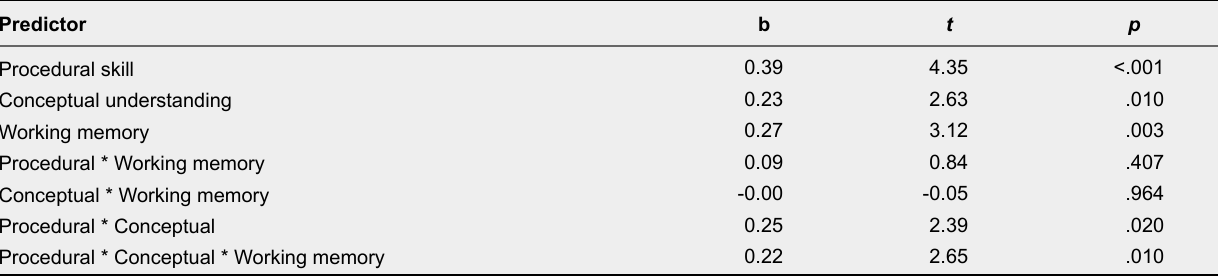
Multiple Linear Regression Predicting Mathematical Achievement by Procedural Skill, Conceptual Understanding, Working Memory and all Interaction Terms Predictor